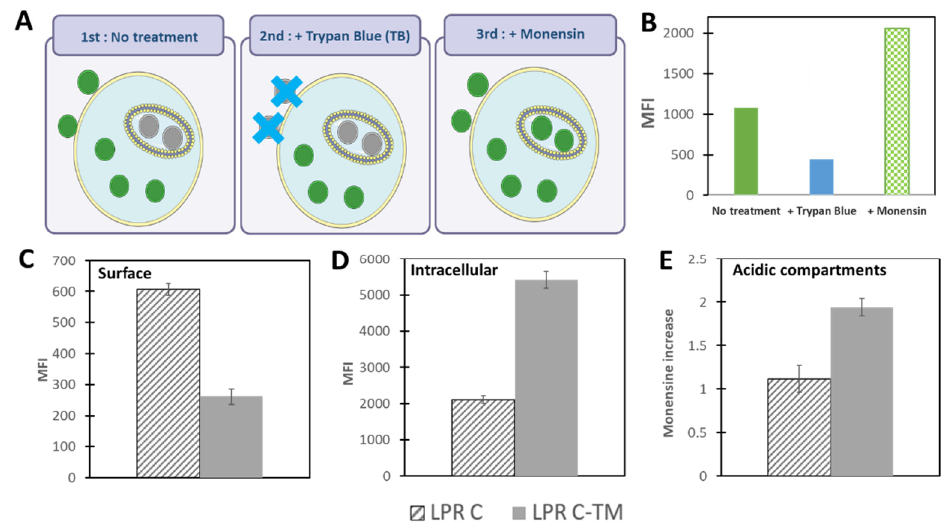
Figure 3. Flow cytometry study of mRNA NP uptake and localization. ( A ) Schematic representation of uptake study process. Cell-associated fluorescence intensity (MFI: mean fluorescence intensity) was measured in PBS (total florescence) after TB treatment (intra-cellular fluorescence) and after monensin treatment (fluorescence recovery in acidic compartments). ( B ) Histograms showing the effects of different treatments on recorded MFI. ( C – E ) corresponding to the cell surface-associated fluorescence, the intracellular fluorescence and the recovery of quenched fluorescence expressed and monensin increase. Shown are unpublished results corresponding to murine dendritic (DC2.4) cells incubated for 4 h with cationic mRNA–lipopolyplexes (LPR C) or cationic mRNA–lipopolyplexes bearing a trimannose ligand (LPR C-TM), without serum.